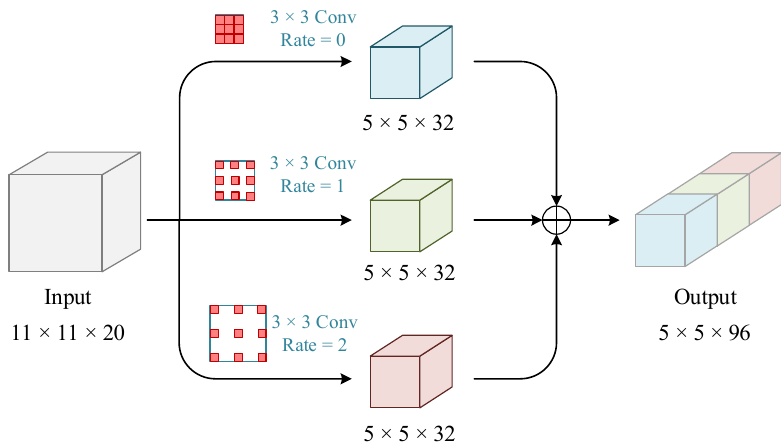
Figure 2. Structure of the multi-scale dilated convolution module.